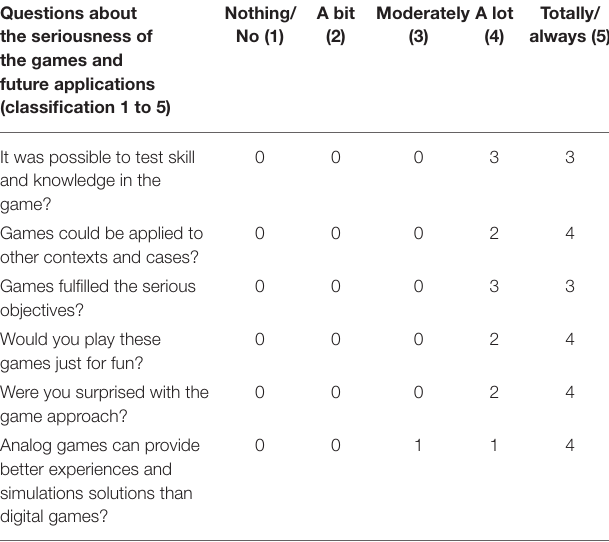
TABLE 4 | Questions about the serious game dimensions of the tested games. Questions about the seriousness